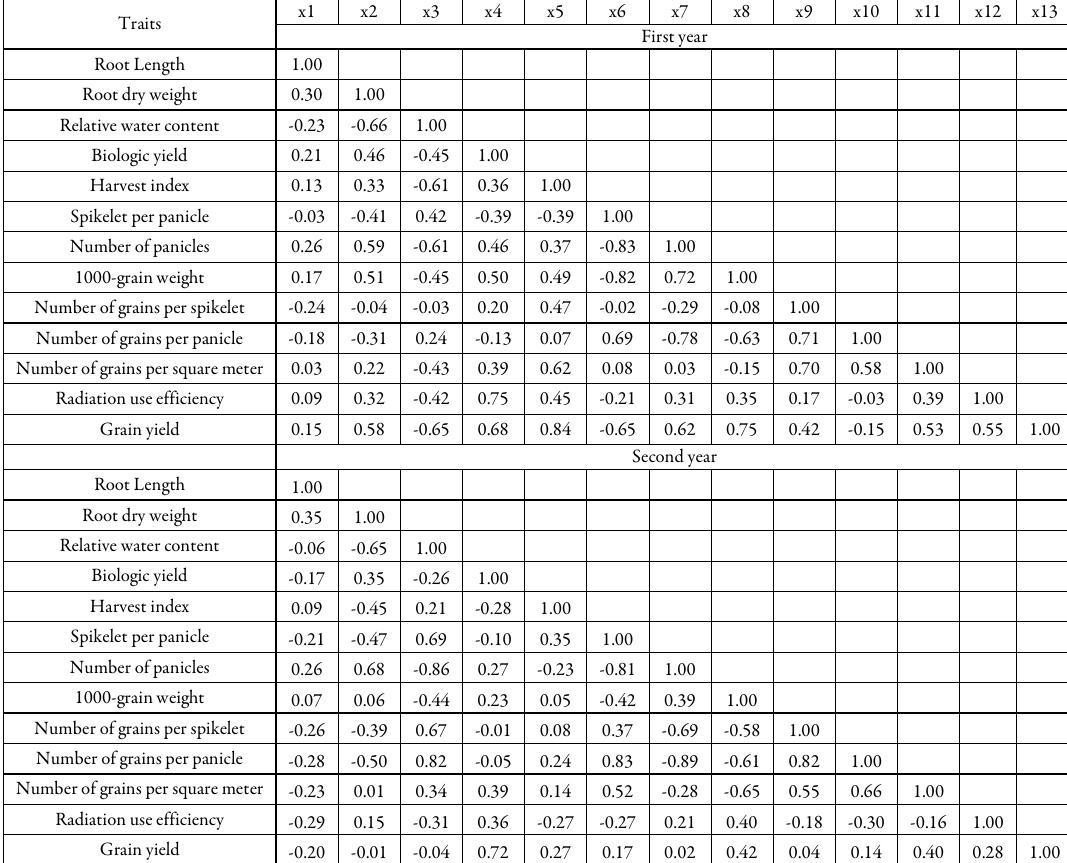
Table 7 . Correlation analysis between different studied traits at two crop